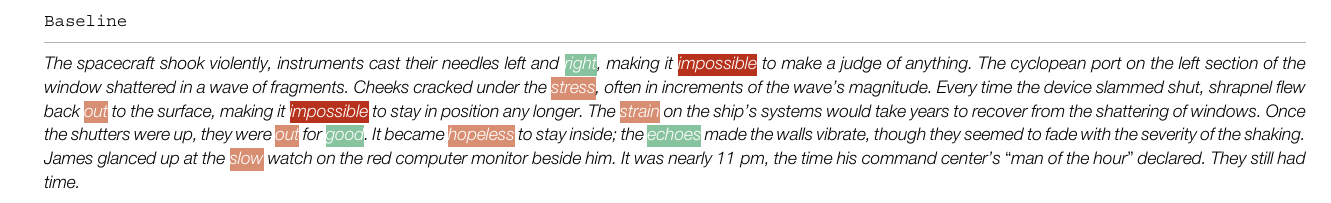
TABLE 15 | Example stories generated with Negative sentiment steering.